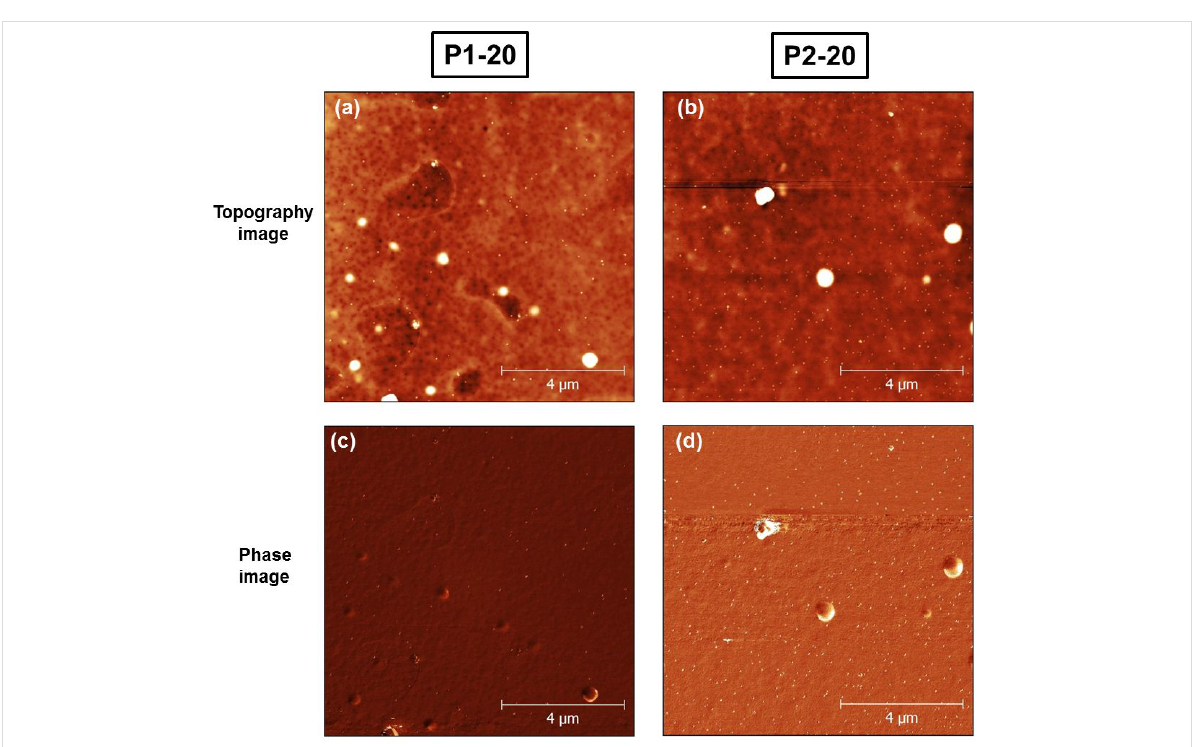
Figure 2: (a,b) AFM topography and (c,d) phase images of 20 wt % Au–PMMA nanocomposites of samples with low M w (P1-20) and high M w